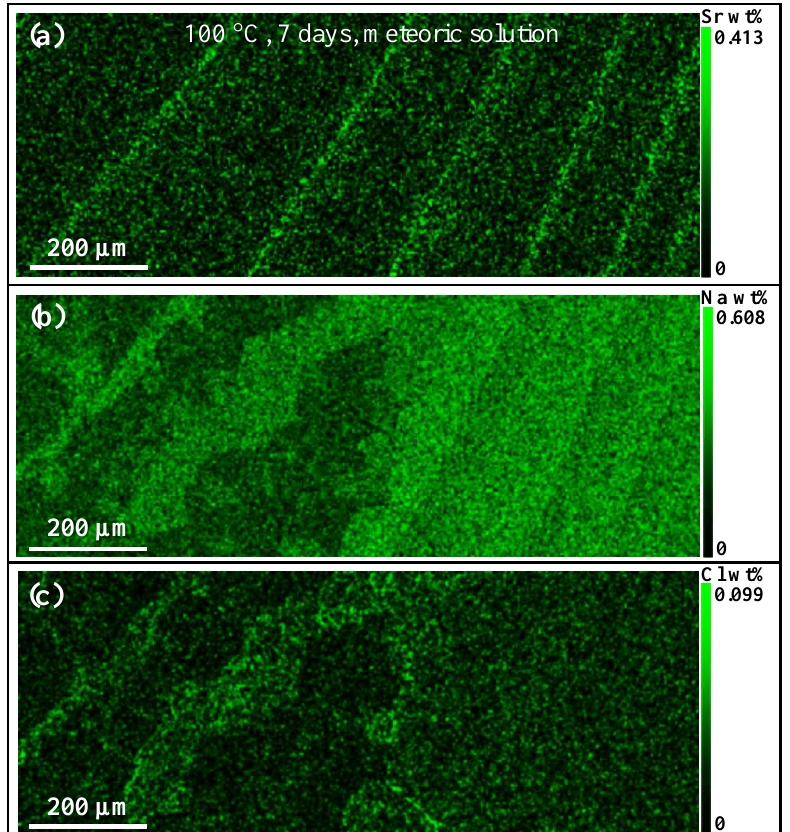
Figure A4. Sr 2 + , Na + , and Cl − concentrations along annual growth lines in a hydrothermally altered shell portion of Arctica islandica . The alteration fluid is NaCl-rich, simulating meteoric waters. The degree of fluid infiltration into and through the shell is well traceable with Na + and Cl − concentrations. Infiltration occurs, in addition through pores, along growth lines that act as conduits for fluid